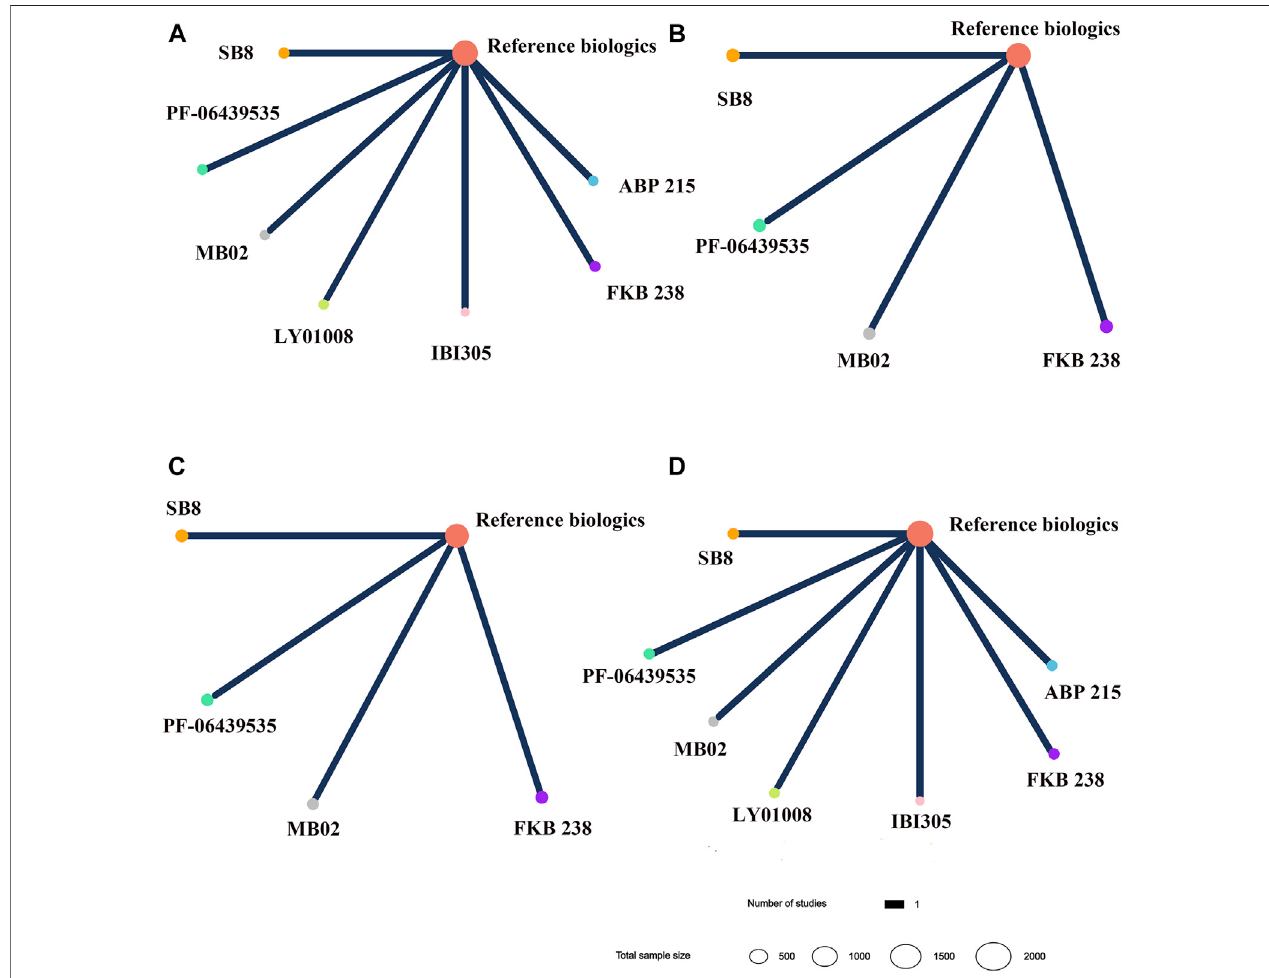
FIGURE 5 | Network plots for different biosimilars and reference biologics in non-small cell lung cancer patients. (A) Objective response rate. (B) Progression-free survival. (C) Overall survival. (D) Incidence of grade 3 – 5 adverse events. Different colors of nodes indicated different treatments. The size of nodes corresponded to the number of participants investigating treatment. The thickness of the edge represented the number of trials. The lack of lines suggested that there are no head-to-head trials for this outcome between the two treatments.